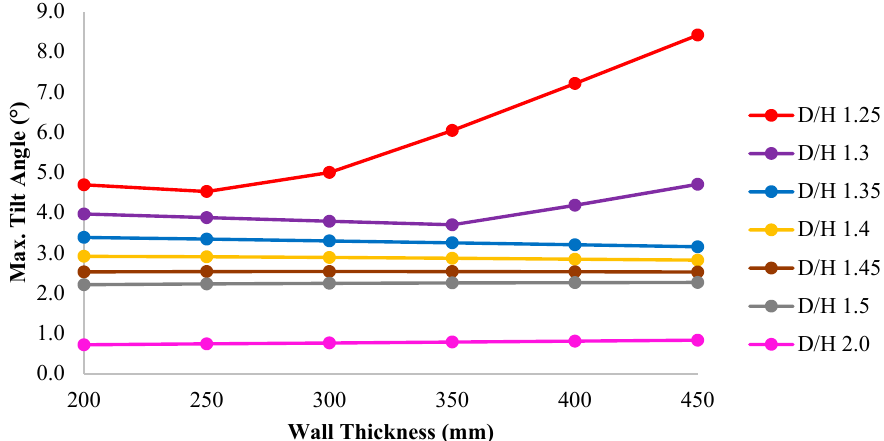
Figure 19. Effect of wall thickness on tilting angle for 5000 m 3 tank (L/D = 1.05) under working environmental condition.